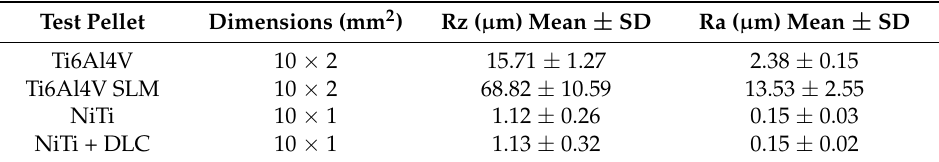
Table 1. Dimensions as well as values of roughness of the test samples.